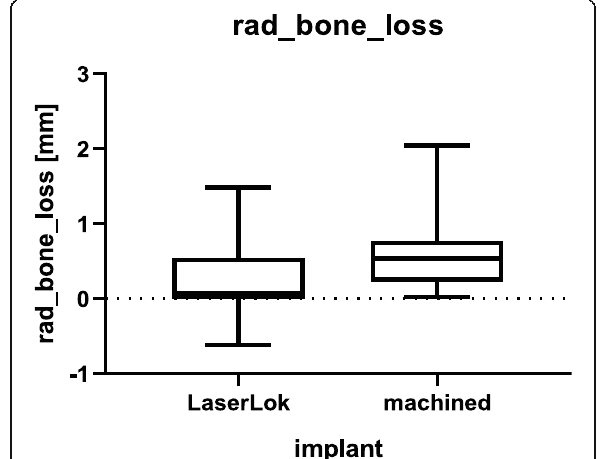
Fig. 3 Radiologic bone loss in